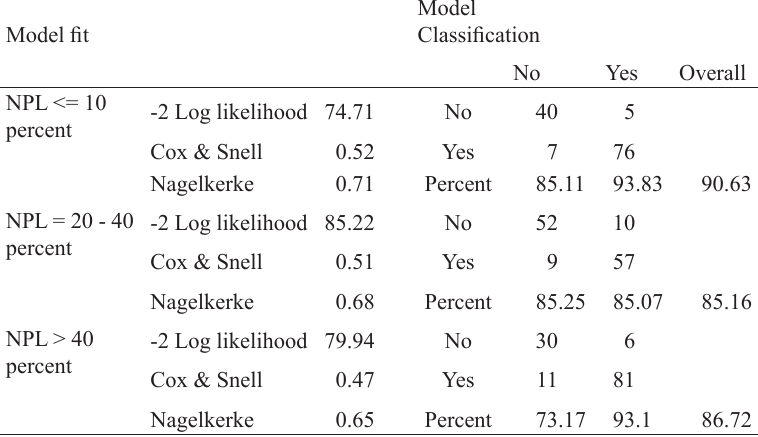
Determinants of the Different Levels of PLR (HIGH) Models Summary